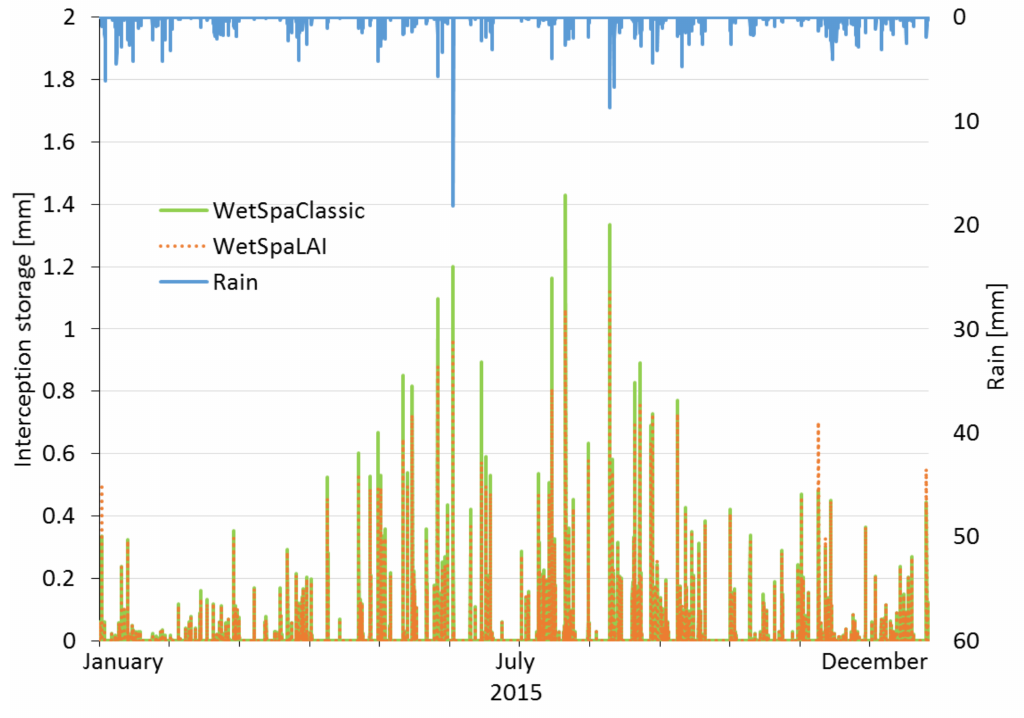
Figure 10. Comparison between WetSpaClassic and WetSpaLAI for the interception storage for the Watermaelbeek in 2015. In winter, WetSpaLAI shows higher interception storage, and in summer, WetSpaLAI shows lower interception storage than